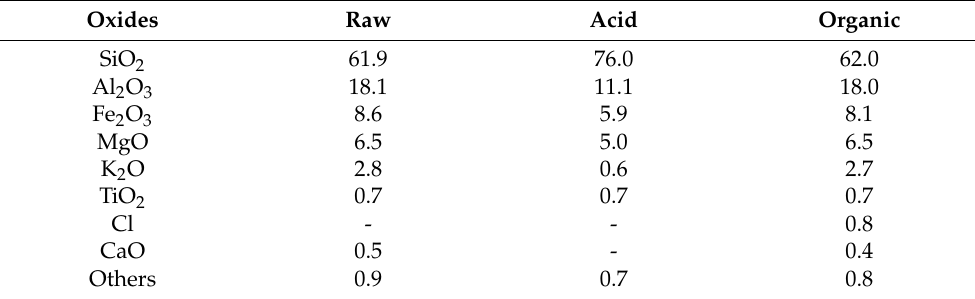
Table 2. Chemical composition (wt%) of the raw and functionalized